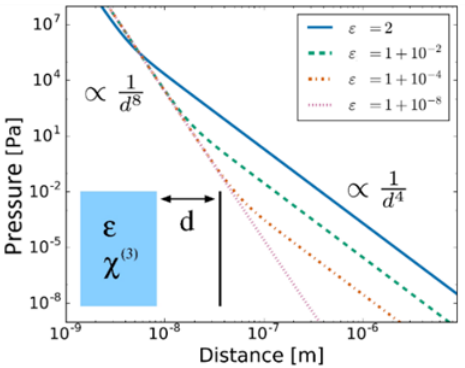
Figure 4. Casimir pressure between a perfect mirror and a nonlinear material (see inset sketch), as a function of distance at T = 0 K. For simplicity, the force is given for a real, frequency-independent linear permittivity as labeled, and a symmetric nonlinear response, 𝜒 𝑖𝑖𝑘𝑘(3) = 𝜒 𝑖𝑘𝑘𝑖(3) = 𝜒 𝑖𝑘𝑖𝑘(3) = 𝜒 𝑖𝑖𝑖𝑖(3) /3 = 2 × 10 −16 𝑚 , with a value measured for glass fused with silver nanoparticles [72]. Figure adapted from Reference [70].